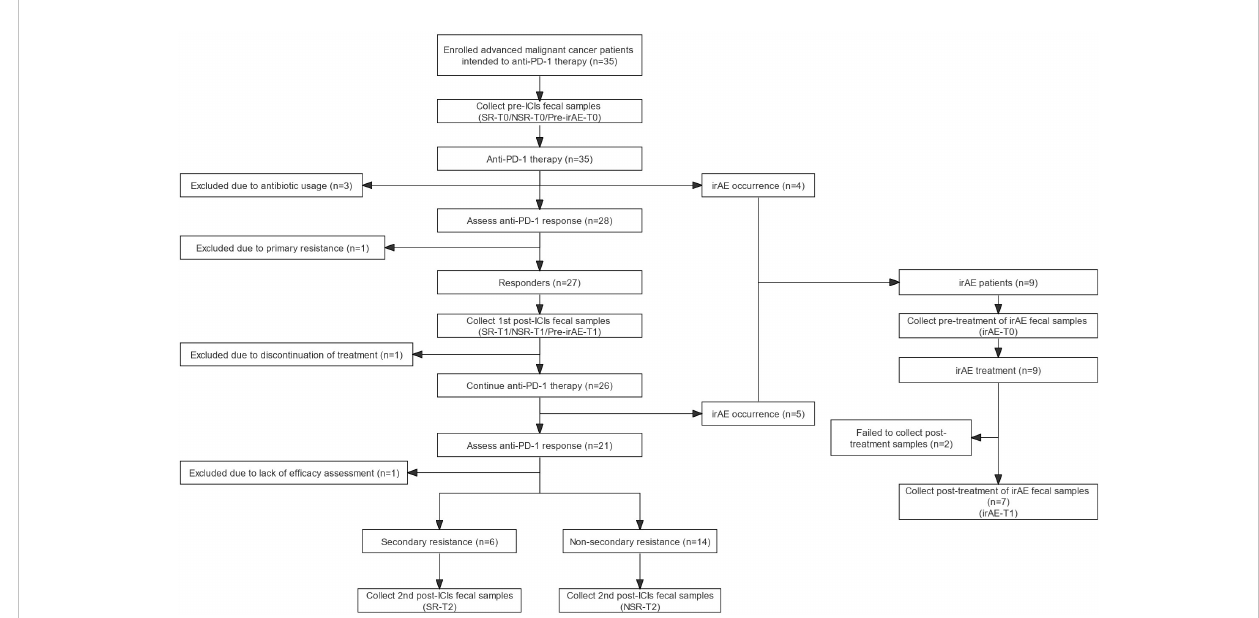
FIGURE 1 Flow diagram of participants and fecal sample collection. Flow diagram of enrollment and follow-up of patients receiving anti-PD-1/PD-L1 therapy. anti-PD-1, anti-programmed death-1; ICI, immune checkpoint inhibitor; irAE, immune-related adverse event; irAE-T 0 , irAE patients - after irAE occurrence; irAE-T 1 , irAE patients - after irAE remission; NSR, non-secondary resistance; NSR-T 0 , non-secondary resistance patients - before ICI treatment; NSR-T 1 , non-secondary resistance patients - primary response after ICI treatment; NSR-T 2 , non-secondary resistance patients - durable response after ICI treatment; PD-L1, programmed death-1 ligand; Pre-irAE-T 0 , irAE patients - baseline before ICI treatment; Pre-irAE-T 1 , irAE patients - after ICI treatment without irAE occurrence; SR, secondary resistance; SR-T 0 , secondary resistance patients - before ICI treatment; SR-T 1